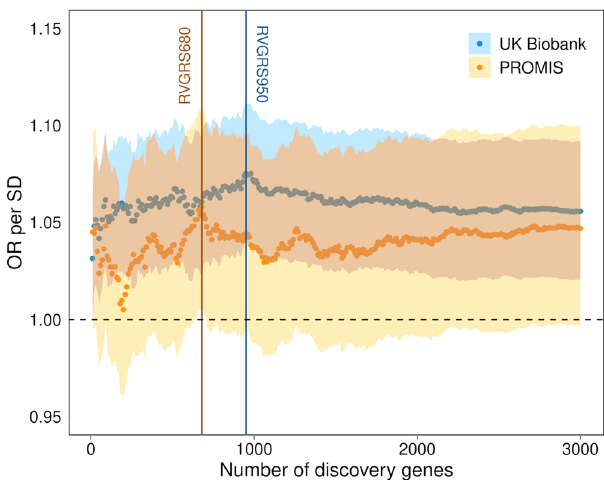
Fig. 8 Predictive effect of RVGRS on CAD evaluated in UK Biobank Europeans and PROMIS South Asians. Odds ratios of 300 RVGRSs generated using the top 10 to top 3000 discovery genes (in intervals of 10) on CAD are shown for Europeans in the UK Biobank (blue points) and South Asians in PROMIS (orange points). RVGRS950 and RVGRS680 correspond to the RVGRS that achieved the strongest association in the UK Biobank Europeans and PROMIS South Asians, respectively. Odds ratios are expressed in terms of a 1 SD change in RVGRS and were adjusted for age, age 2 , sex, and the fi rst 20 principal components of ancestry using a multivariable logistic regression model. Each point represents the odds ratio per 1 SD change in RVGRS on CAD. Shaded regions correspond to 95% con fi dence interval of the odds ratio. Dashed line represents a line of no effect. OR indicates odds ratio, SD indicates standard deviation, RVGRS950 refers to rare variant genetic risk score from the top 950 discovery genes, and RVGRS680 refers to rare variant genetic risk score from the top 680 discovery genes. Source data are provided as a Source data fi